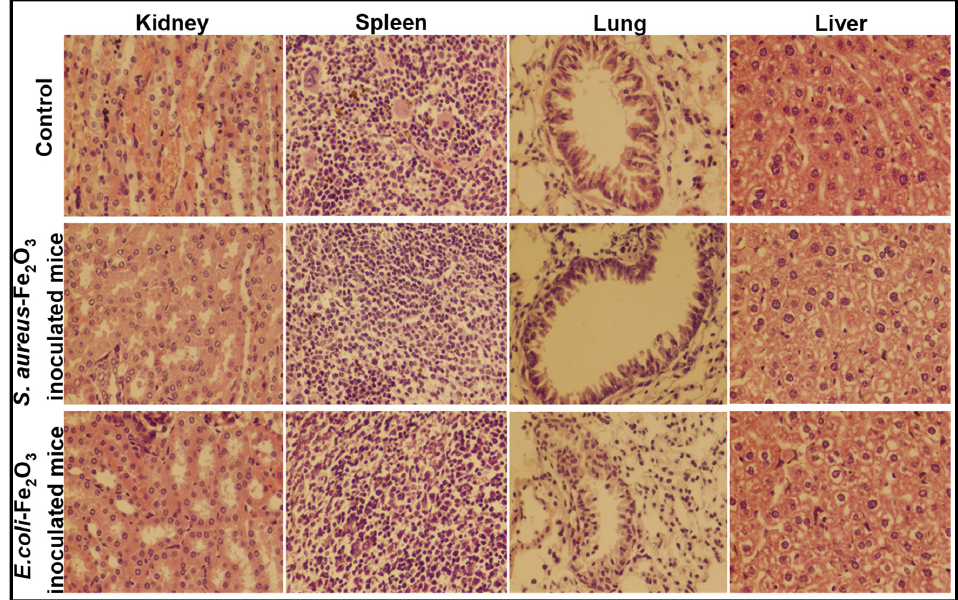
Figure 9. The histopathological examination of the kidney, spleen, lung and liver of mice after the simultaneous inoculation of the tolerated concentration of both Fe 2 O 3 NPs (14 ppm) and bacterial suspension (3 × 10 − 7 CFUs).